Question: Author a descriptive caption for the visualization shown.
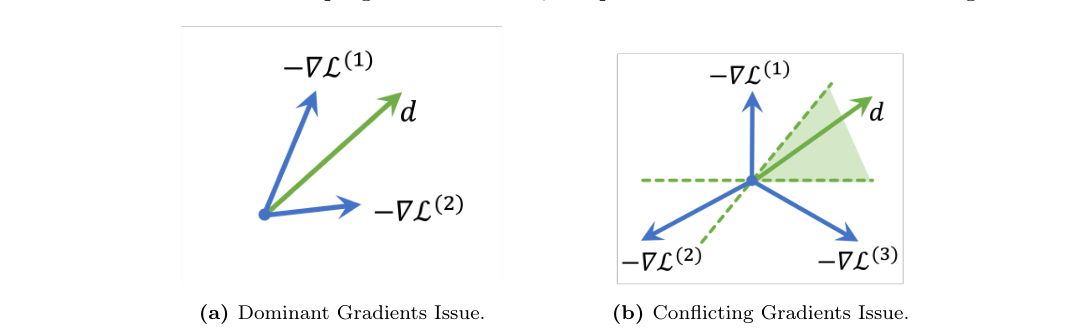
Answer: (a)dominant gradients issue. The update direction d is dominated by the negative gradient of the loss of task 1. (b)conflicting gradients issue. When {α(t)}3 t=1 are not properly set, the update direction d can decreases the loss of task 1 and 3 while increases the loss of task 2. Therefore, the pefromance on the task 2 is compromised.